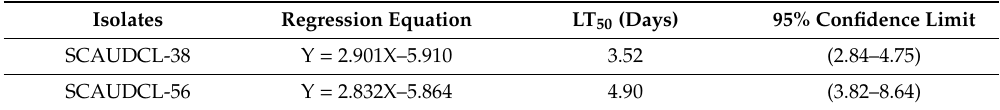
Table 4. Median lethal time (LT 50 ) values for 1 × 10 8 conidal / mL of A. attenuatus isolates SCAUDCL-38 and SCAUDCL-56 against M. usitatus .